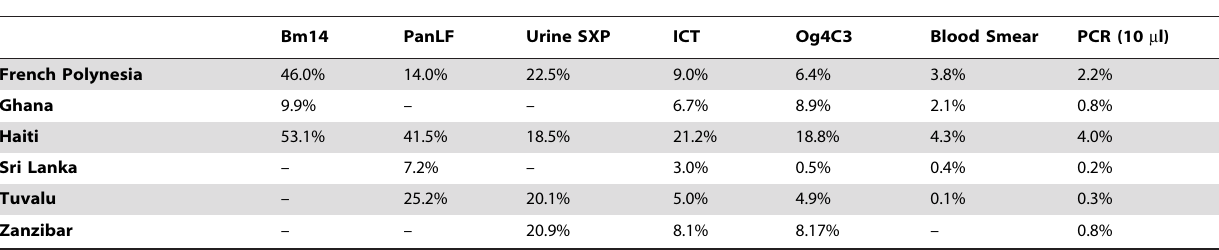
Table 7. Prevalence of positive results by test and country.